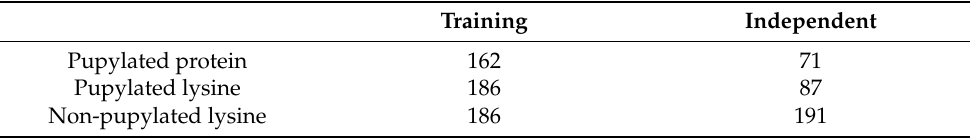
Table 4. The number of pupylated proteins and pupylation sites. Training Independent Pupylated protein 162 71 Pupylated lysine 186 87 Non-pupylated lysine 186